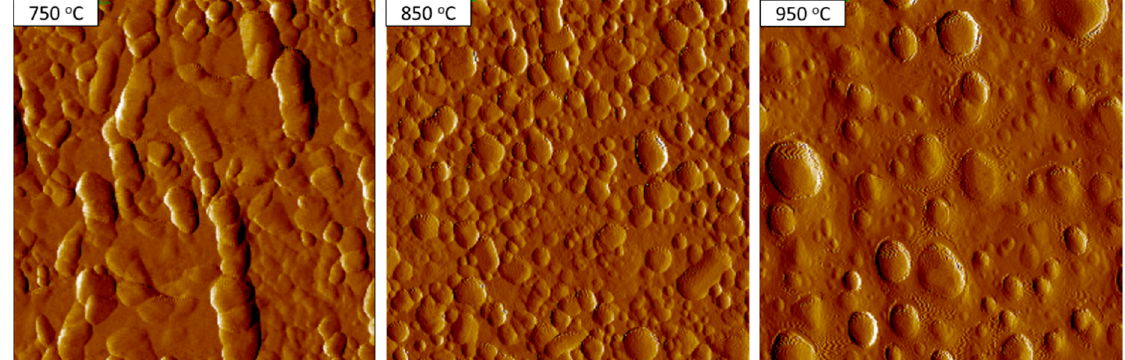
Figure 8. Atomic force microscopy (AFM) images of the catalysts after pretreatment at different temperatures for 10 min.